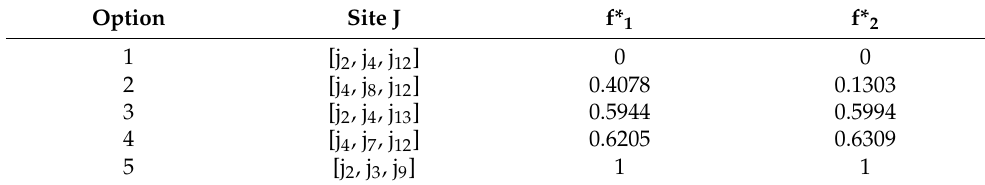
Table 6. The objective function after